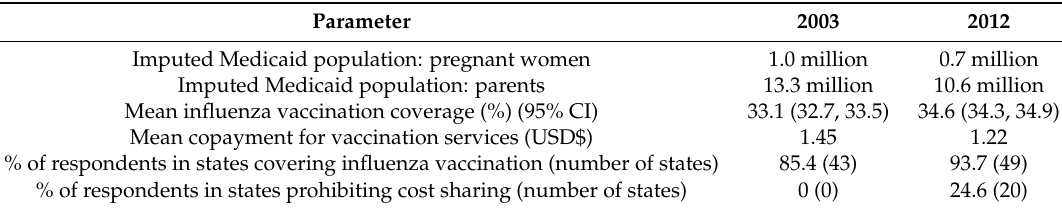
Table 1. Mean vaccination coverage levels and benefits policy parameters for 2003 and